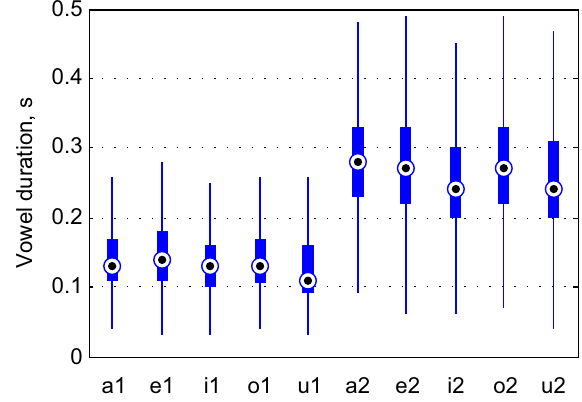
Figure 8. CVC logatomes: duration of central vowels.